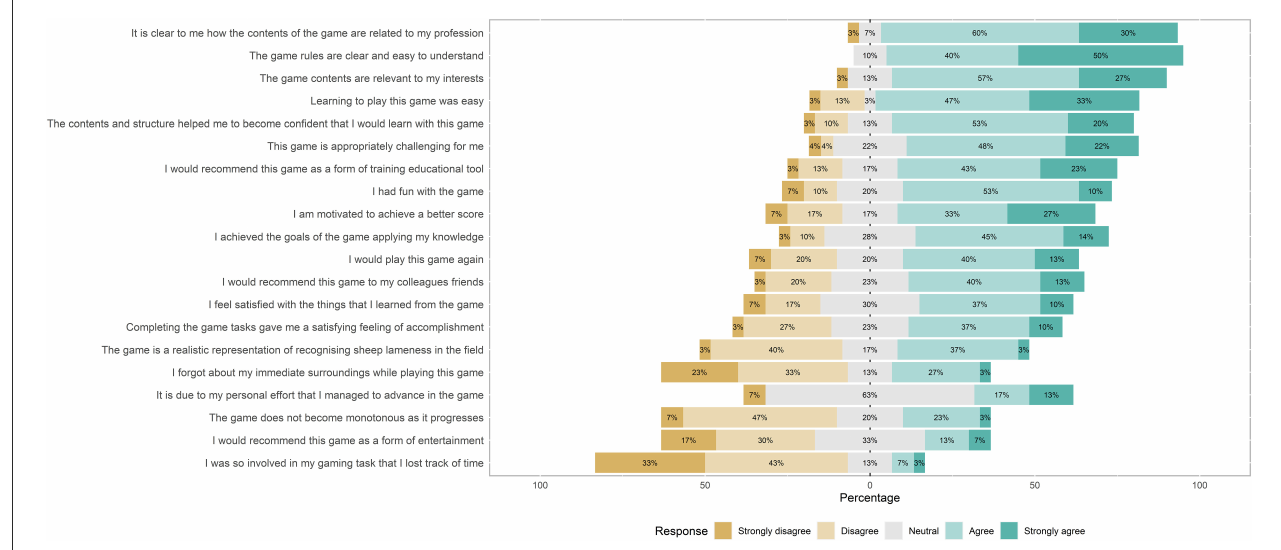
FIGURE7 Quantitative feedback given on the game via a Likert Scale questionnaire. Statement rated are shown on the rows, with the total percentages of participants with farming experience responding negatively, neutrally and positively to the statements overlaid on the stacked bar